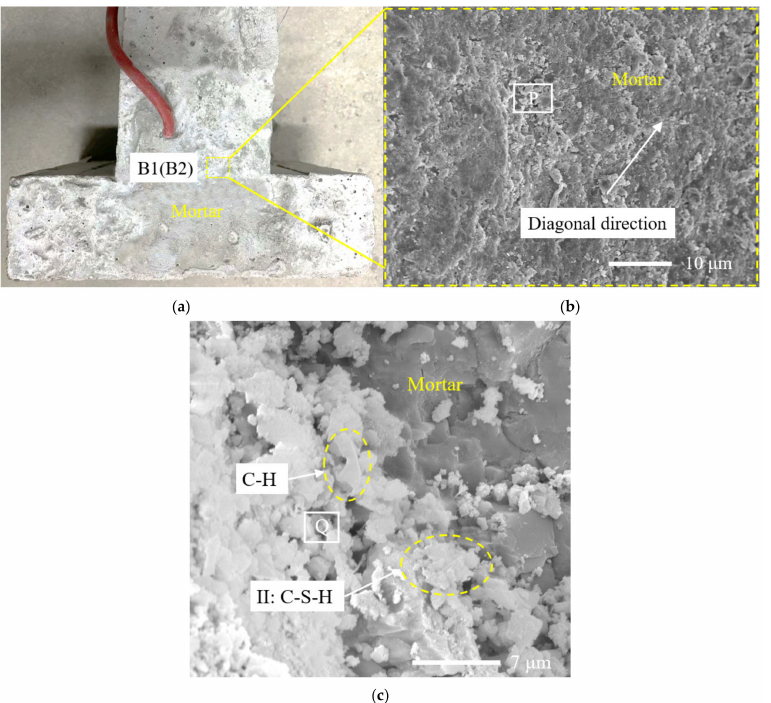
Figure 9. Microstructure and position of specimen 2. ( a ) Position of samples B1 and B2; ( b ) the microstructure of sample B1 and the position of region P; ( c ) the microstructure of sample B2 and the position of region